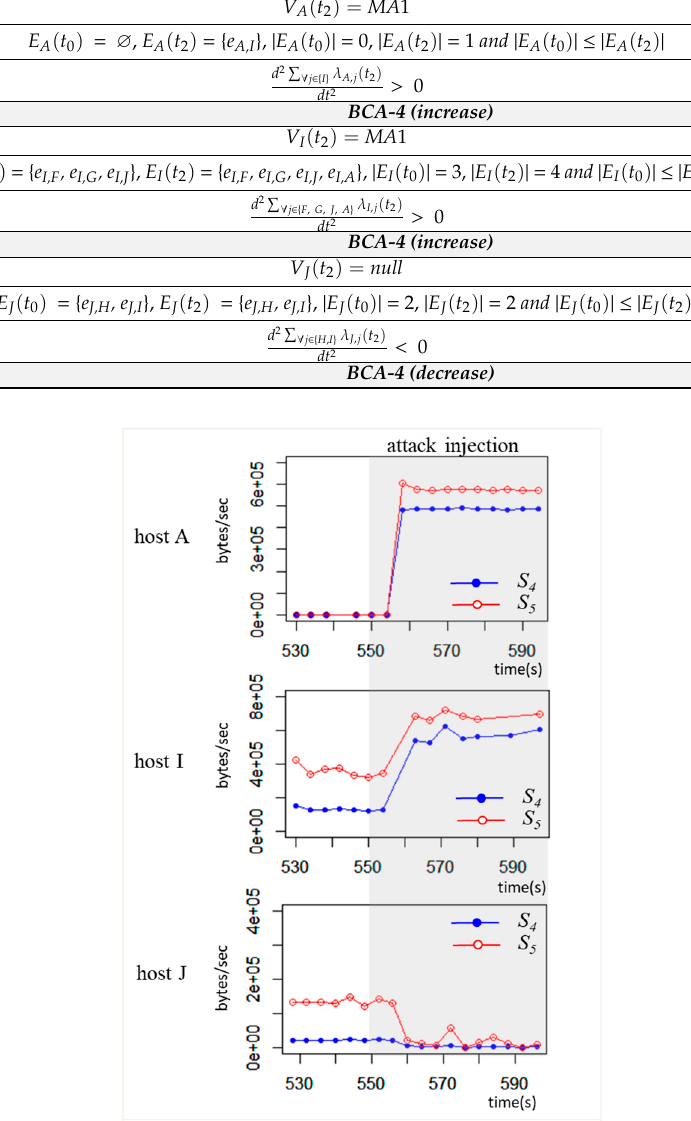
Figure 14. Sudden increase and decrease of tra ffi c by the flooding